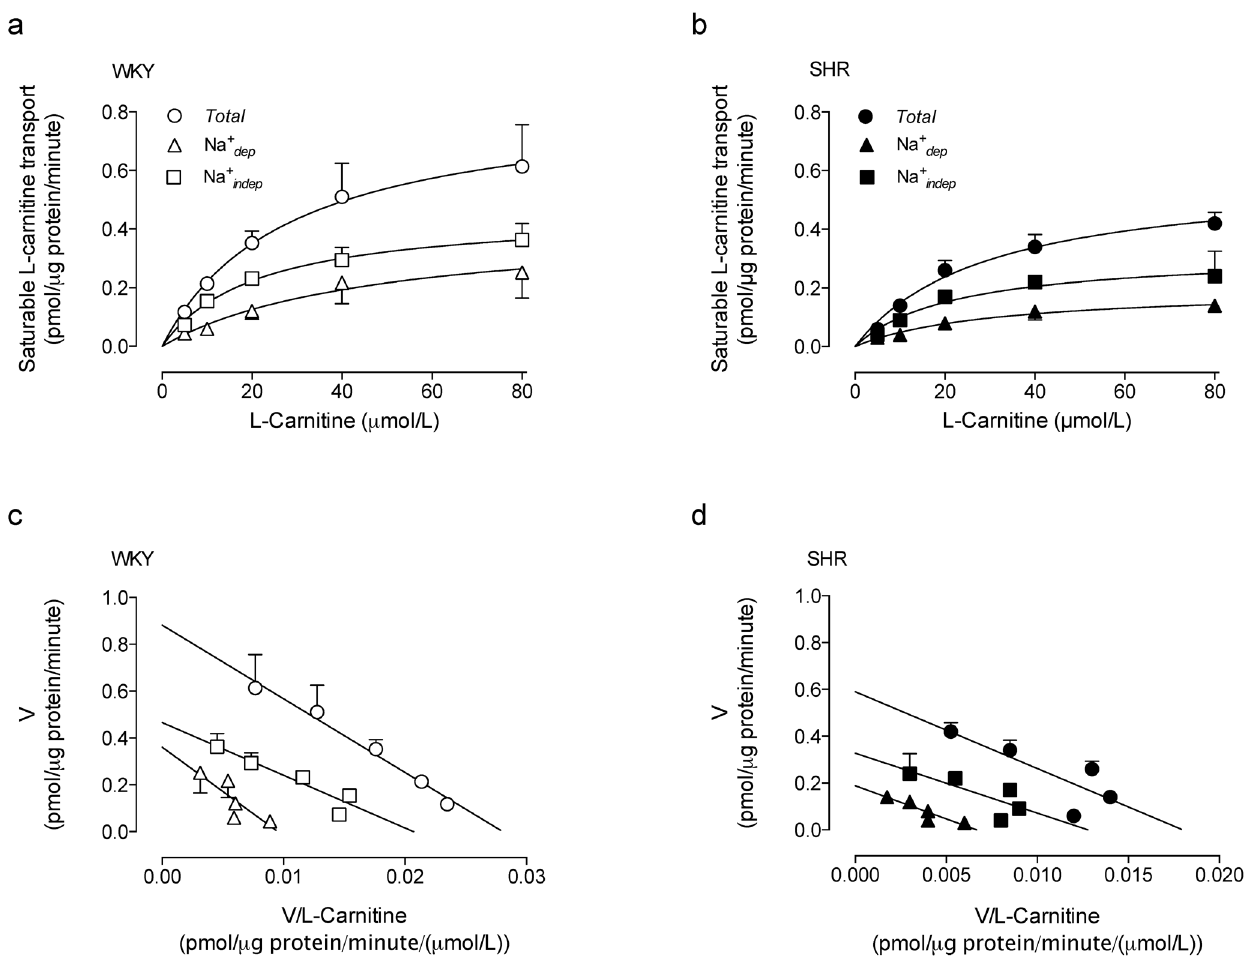
Figure 4. Saturable transport of L-carnitine kinetics. Total saturable transport of L-carnitine ( Total ), and the Na + -dependent (Na + dep ) and Na + - independent (Na + indep ) transport components (0–80 m mol/L L-carnitine, 3 m Ci/mL L-[ 3 H]carnitine, 30 seconds, 37 u C) in RAECs cultures from WKY rats (a) or SHR (b). The Eadie-Hofstee plots for transport data are shown for WKY rats (c) and SHR (d) from data in (a) and (b), respectively. Values are mean 6 SEM (n=15).